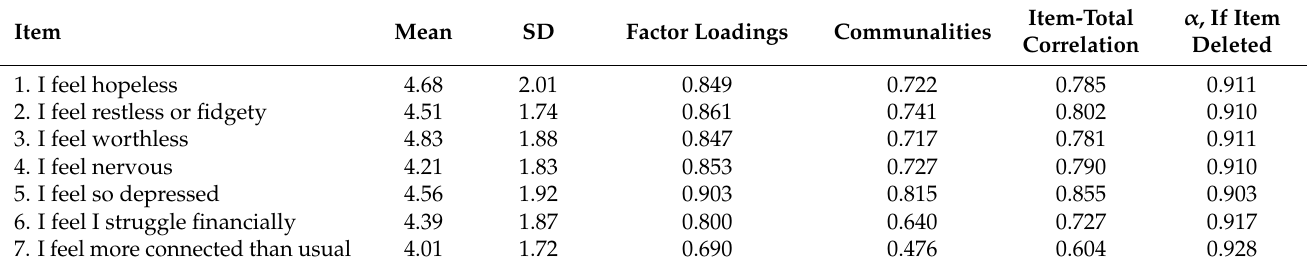
Table A2. Updated factor analysis of C-ESES with factor loading and item—total correlation